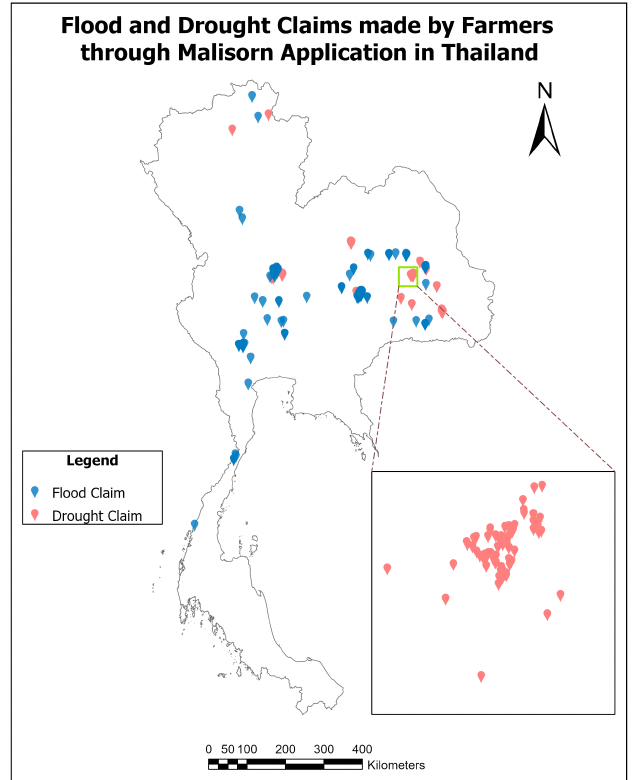
Figure 1. Flood and drought claims made by the farmers from the disaster locations in